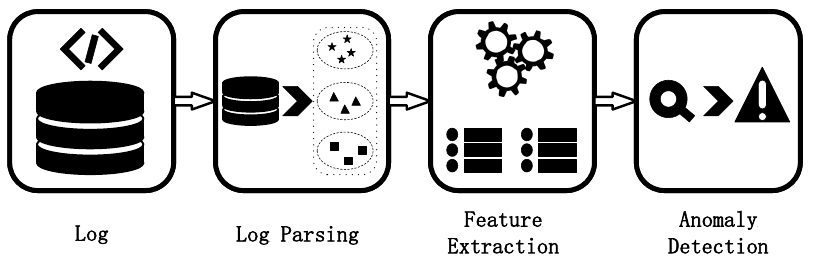
Figure 2. This picture shows the process of log analysis, including log mining, feature extraction, and anomaly